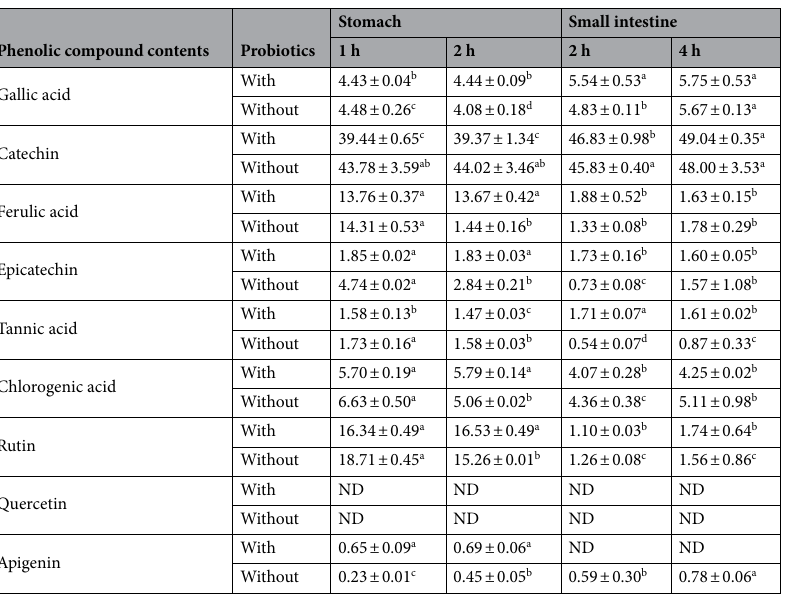
Table 3. Phenolic compound contents (ppm) of yellow vegetable tablets with/without probiotics when passing through the simulated early and middle digestive system. * mean ± standard deviation. ND: not detected. a,b,c,d Different superscript letters (within same row) indicate significant differences ( p ≤